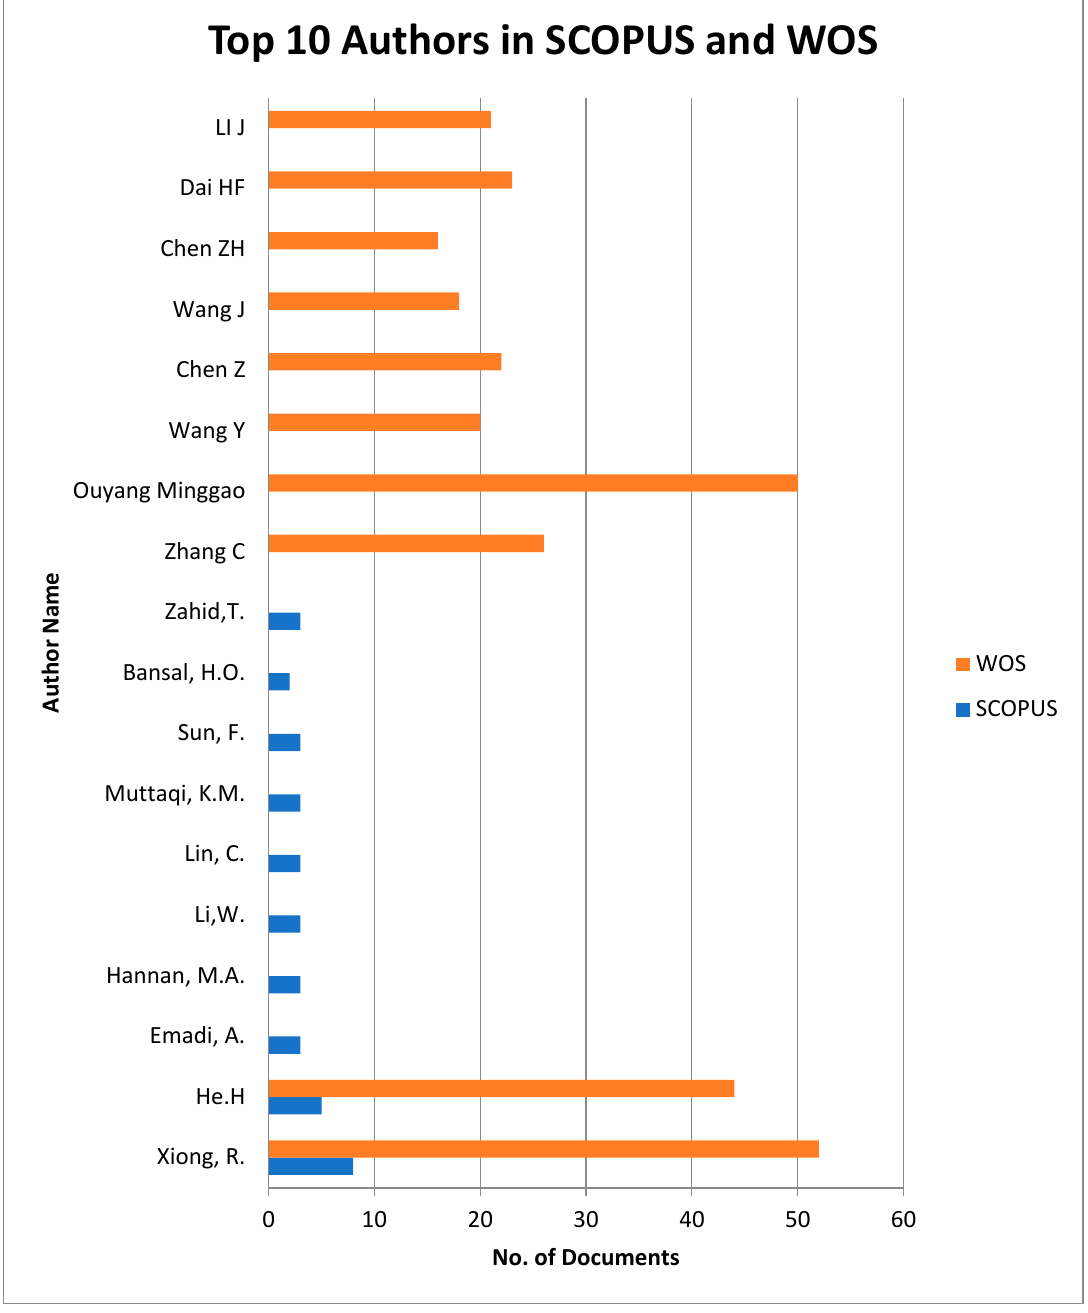
Figure 3. Top ten authors of SCOPUS and WOS DB along with NOPs.